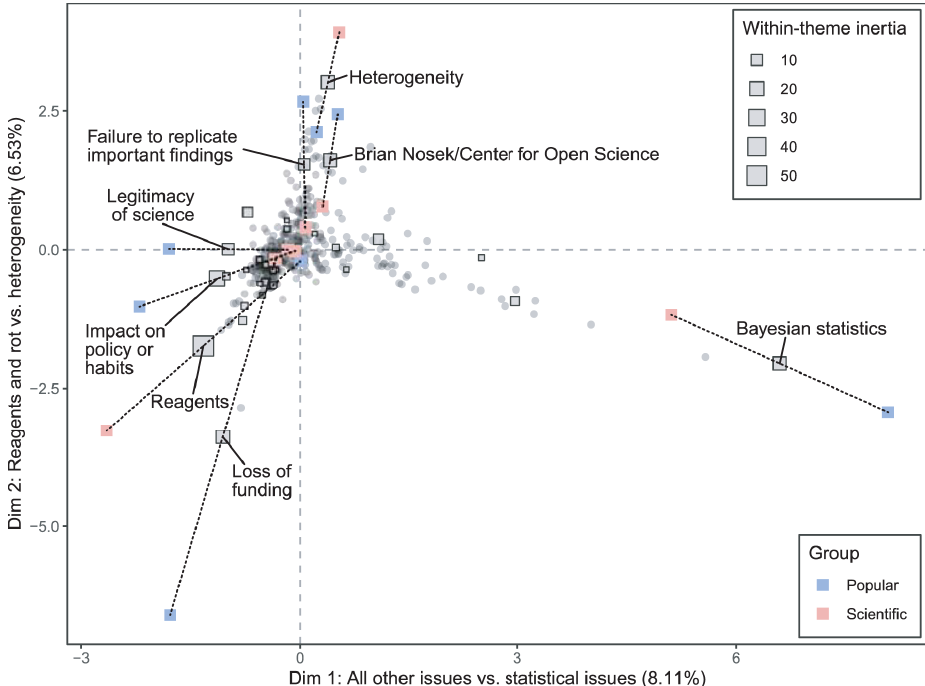
Fig 7. Multiple factor analysis of 353 articles discussing reproducibility, analyzed for 29 themes, with articles grouped by intended audience. The size of the square indicates the degree of within-theme inertia. The eight themes with the greatest within-theme inertia are labeled, and partial points for those themes are displayed. Red points indicate the location of those themes in the group of articles aimed at a scientific audience, and blue points indicate the theme location for the popular audience group. Grey points indicate the location of the articles on the first factor